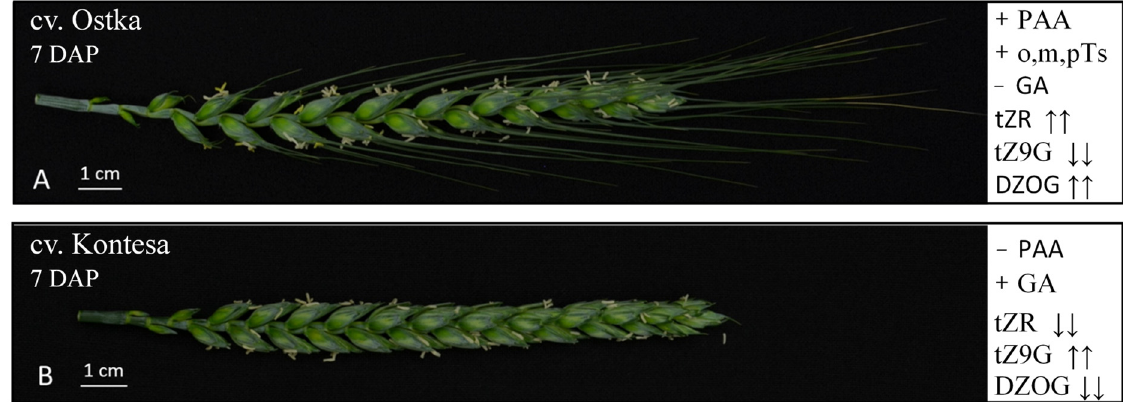
Figure 7. Comparison of composition and contents of phytohormones in 7 DAP spikes of Ostka and Kontesa. + newly detected; − not found; ↑↑ strongly increased; ↓↓ strongly decreased.